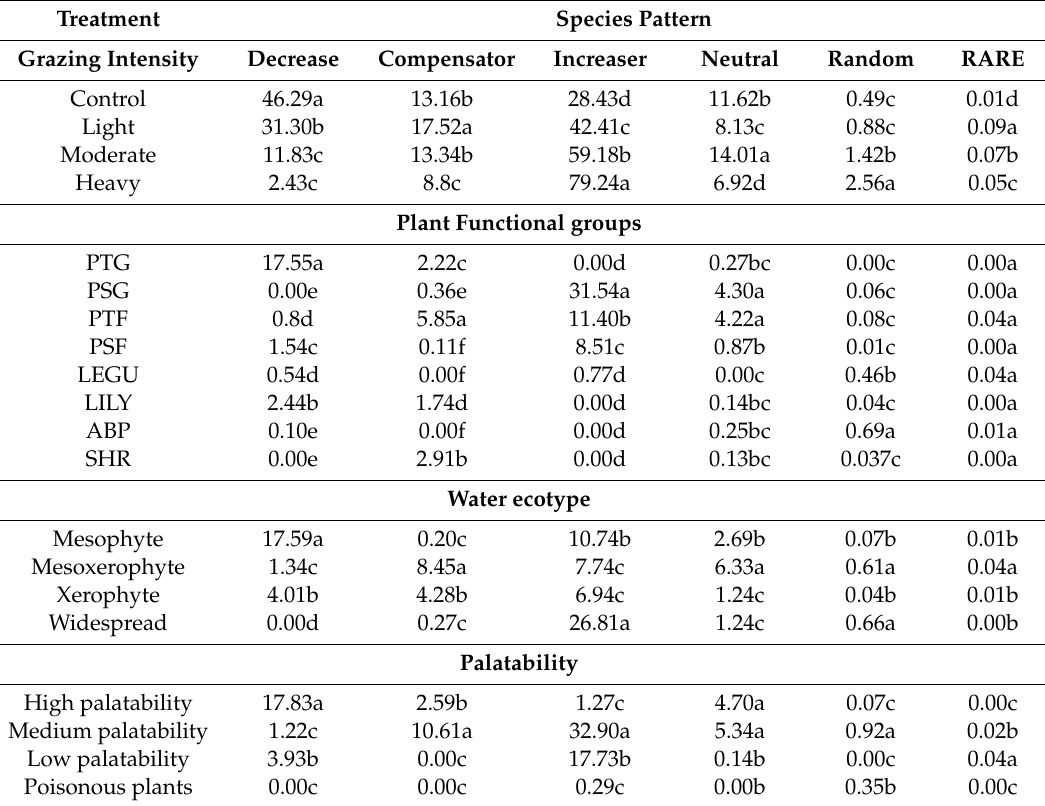
Table 2. Species change pattern along grazing succession and their distribution in di ff erent functional groups, water ecotype and palatability